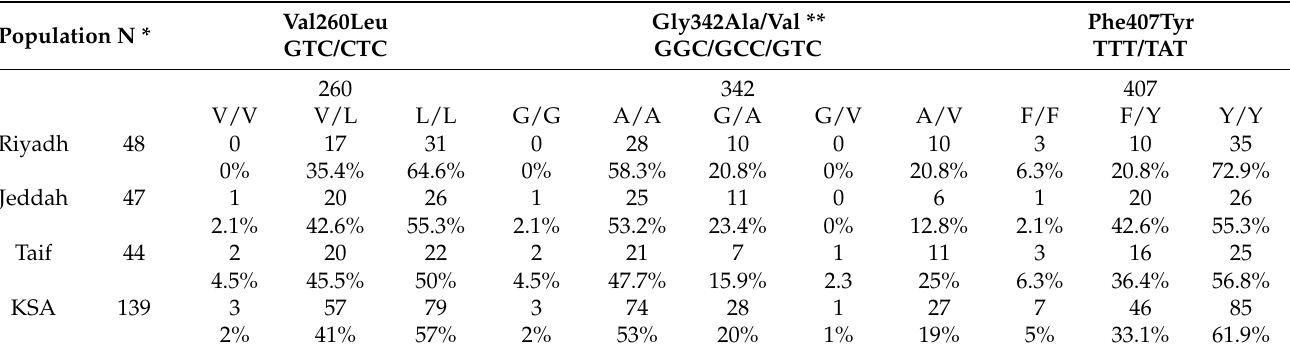
Table 3. Frequency of the three Ace point mutations, associated with OP resistance, in house fly populations, collected from three slaughterhouses in Saudi